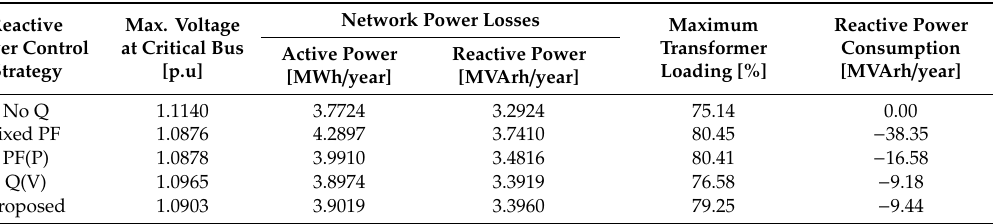
Table 3. Annual results analysis for 2017.